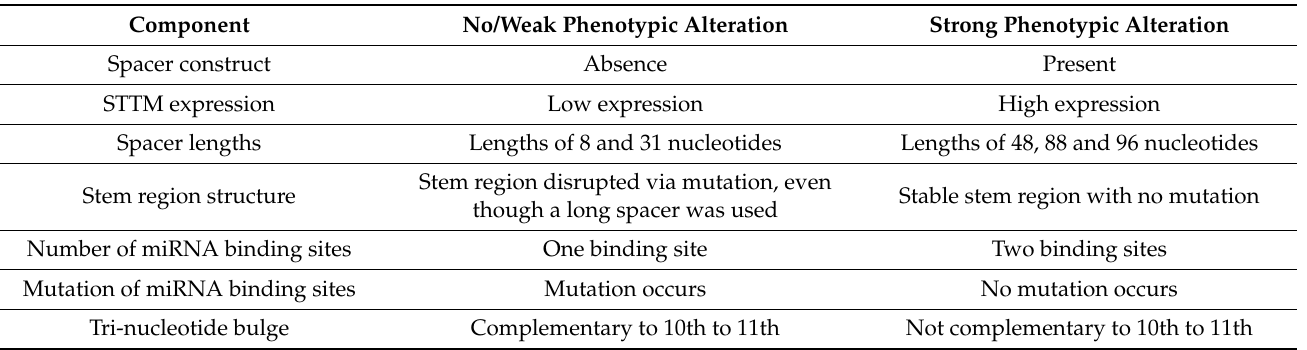
Table 1. Comparison of advancements in the development of STTM components and their correlation with changes in plant